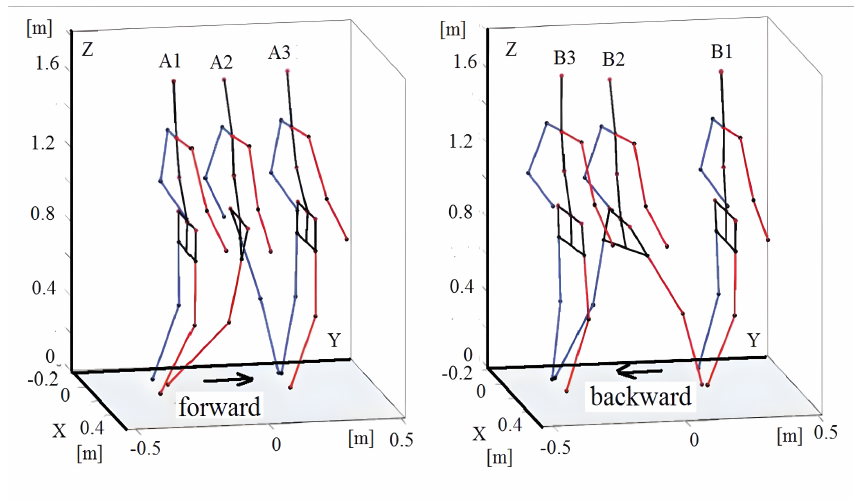
Figure 3. Visualization of events during forward and backward stepping.